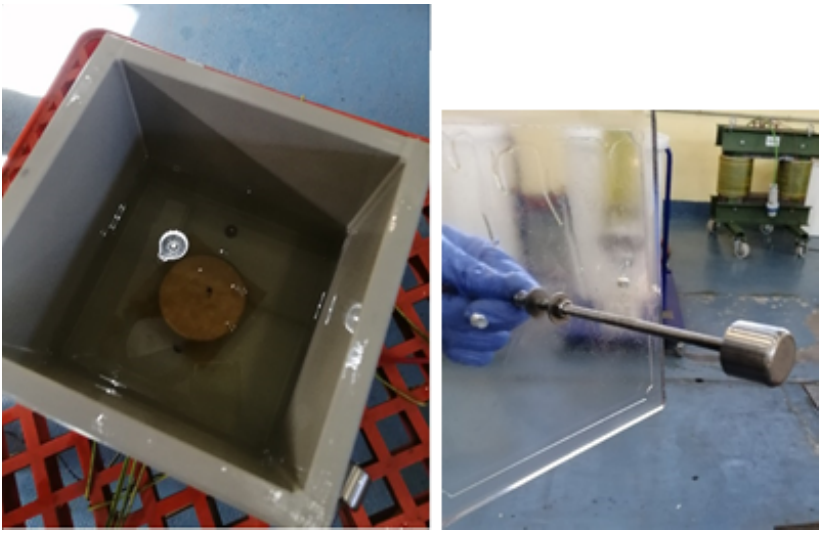
Figure 4. Test cell used in the study.